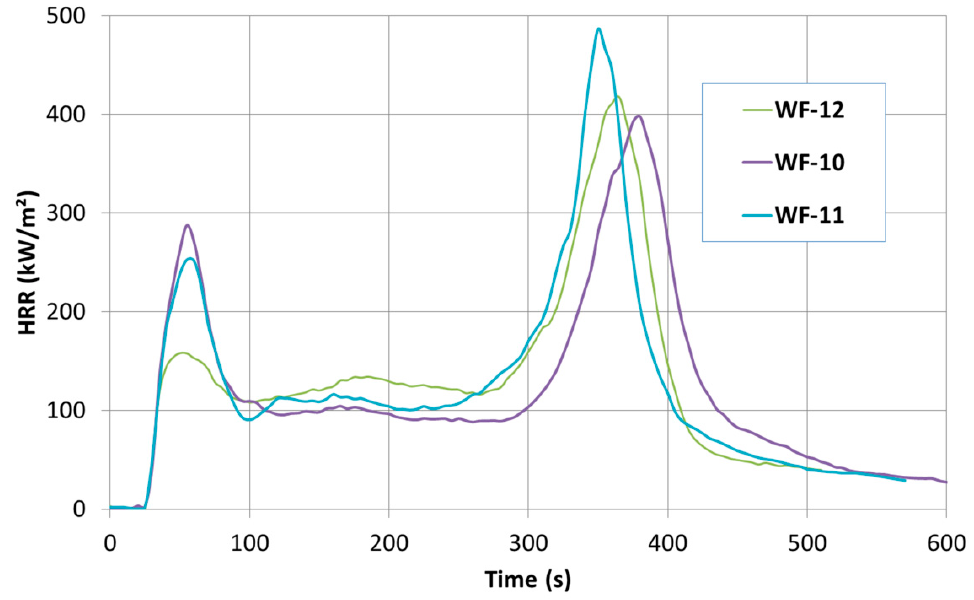
Figure 6. Heat Release Rate (HRR) curves vs. time in the cone calorimeter ISO 5660-1 for coatings WF-10, WF-11 and WF-12.